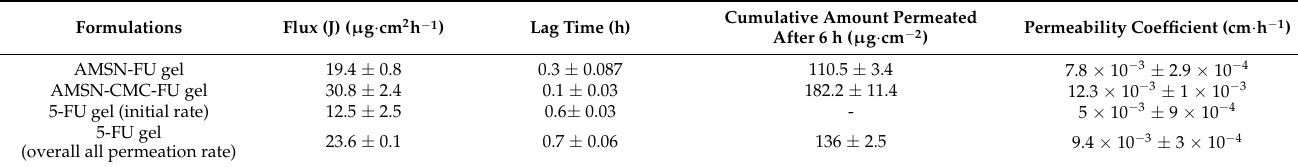
Table 2. Parameters of transcorneal permeation for AMSN-FU gel, AMSN-CMC-FU gel, and 5-FU gel. The values are represented as the mean of three measurements with standard deviation (Mean ± SD, n =